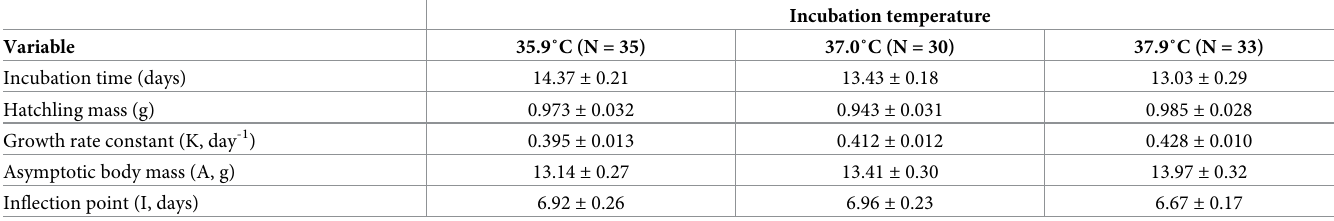
Table 1. Embryonic (incubation time and hatchling weight) and nestling growth parameters for birds incubated at different temperatures.